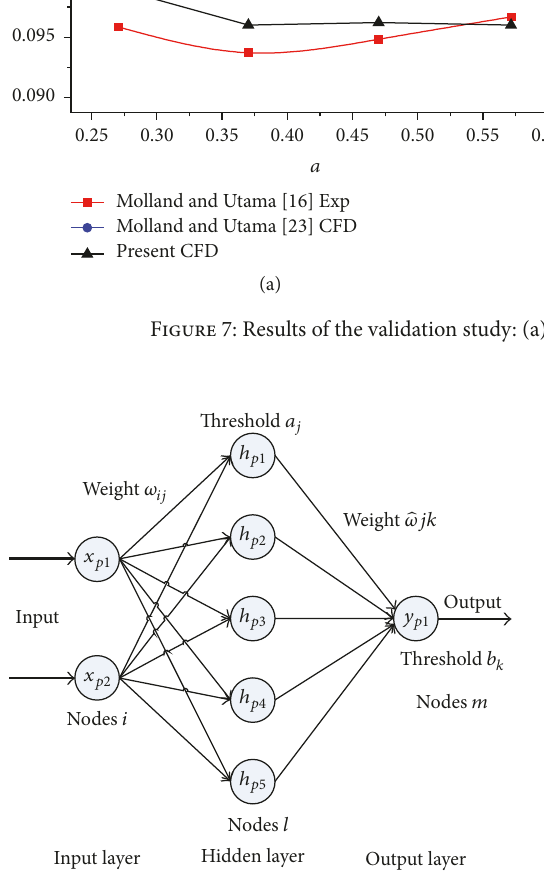
Figure 8: The topology of the